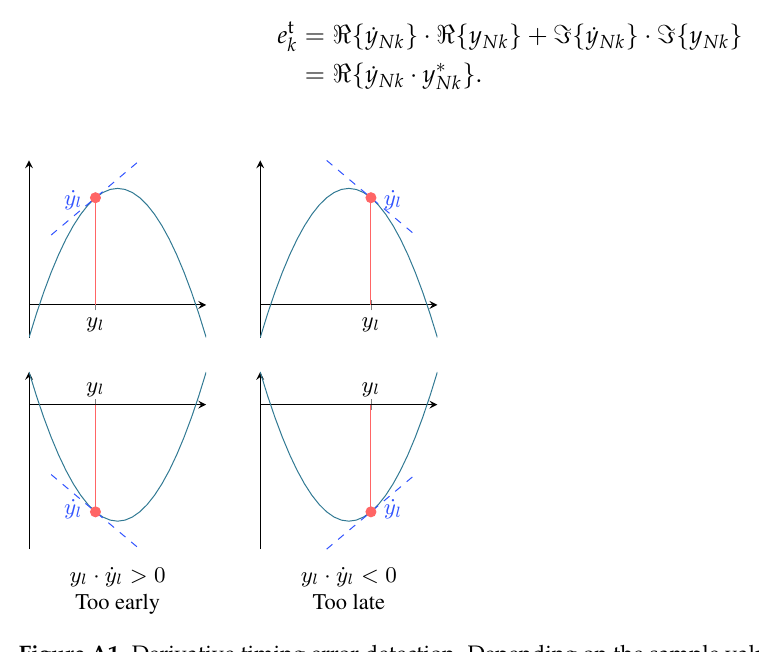
Figure A1. Derivative timing error detection. Depending on the sample value y l and the slope of the signal ˙ y l , we can derive a decision if the sample timing is too late or too